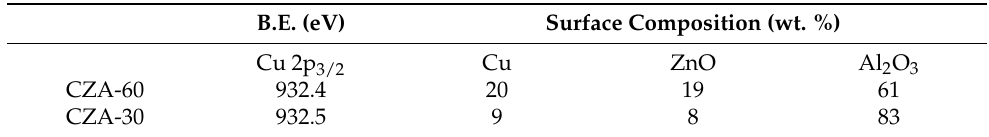
Table 2. Binding Energy and surface atomic elemental compositions of the reduced catalysts obtained by XPS.